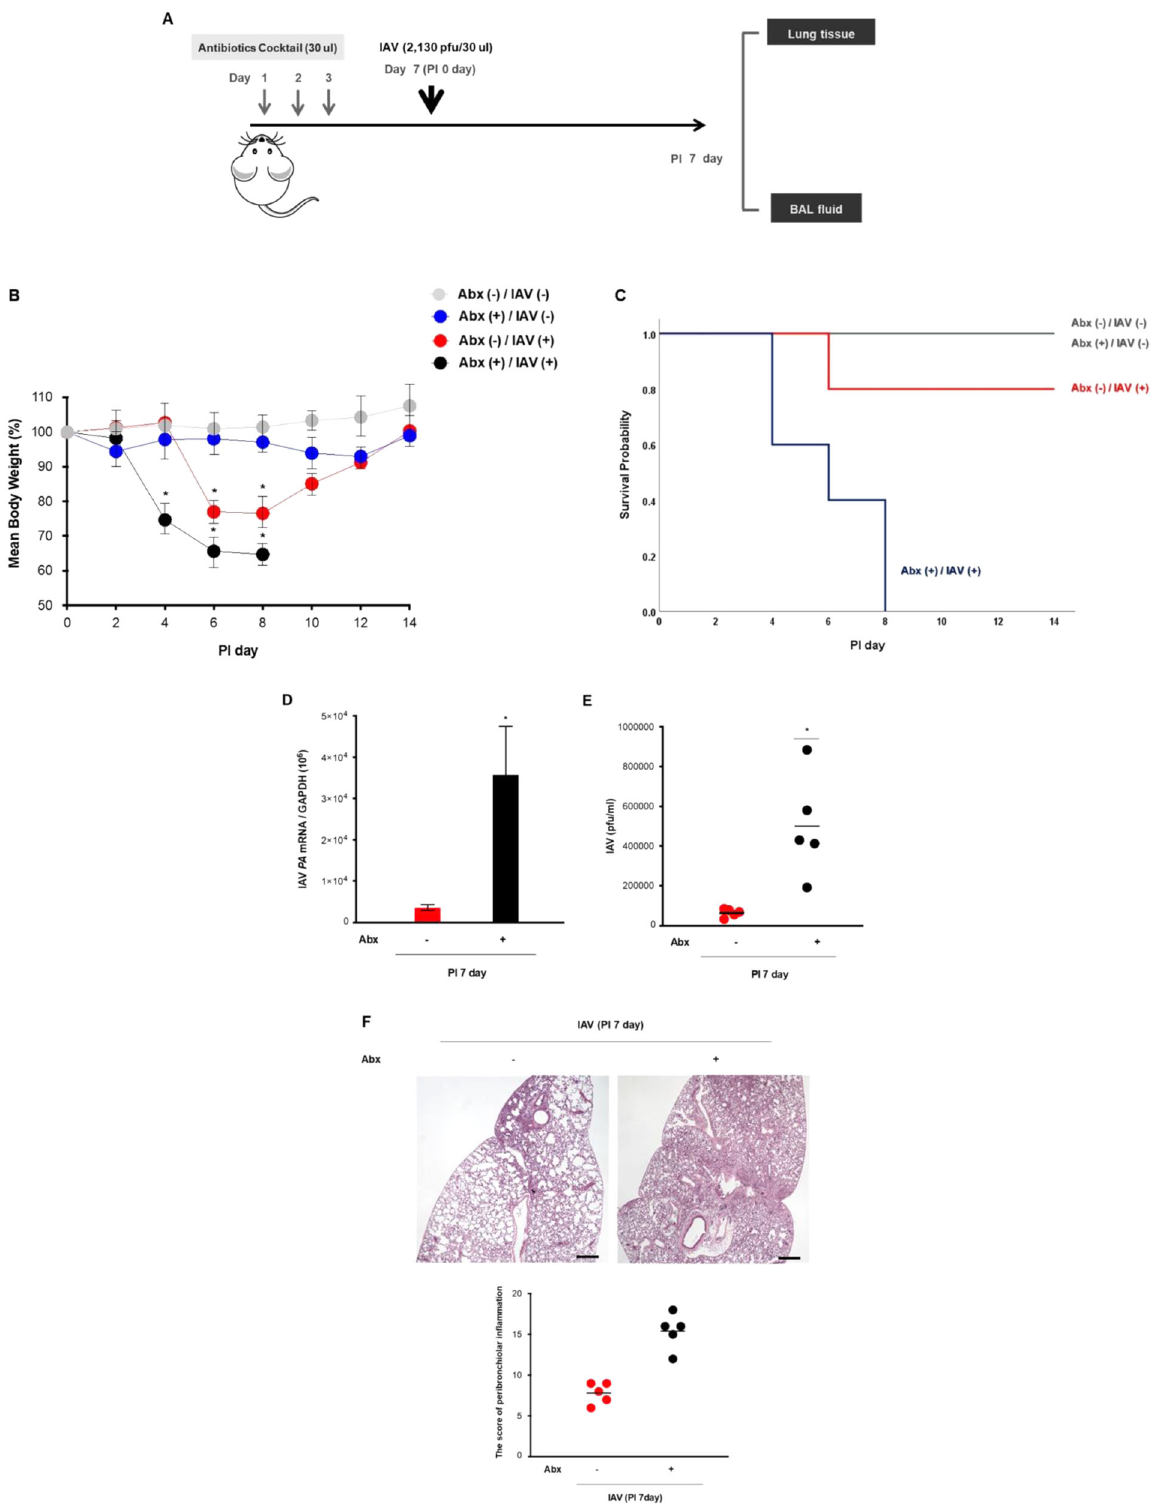
(normalized data (log2): 3.723) was signi fi cantly higher than that of Serpine2 (normalized data (log2): 1,216) in NHNE cells (Table 1). As a next step, we studied the expression kinetics of the human Serpine1 and Serpine2 genes as well as protein production in NHNE cells following inoculation with S. epidermidis . PCR results